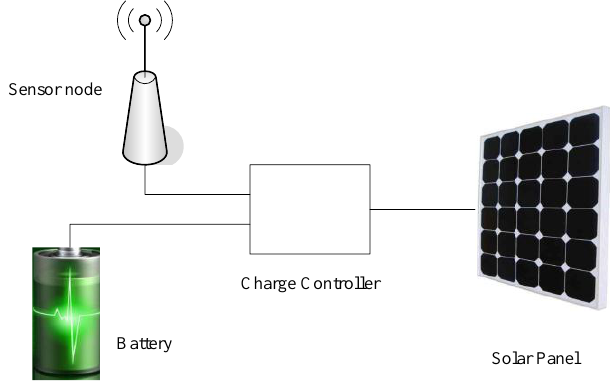
Figure 1. Solar node structure diagram.